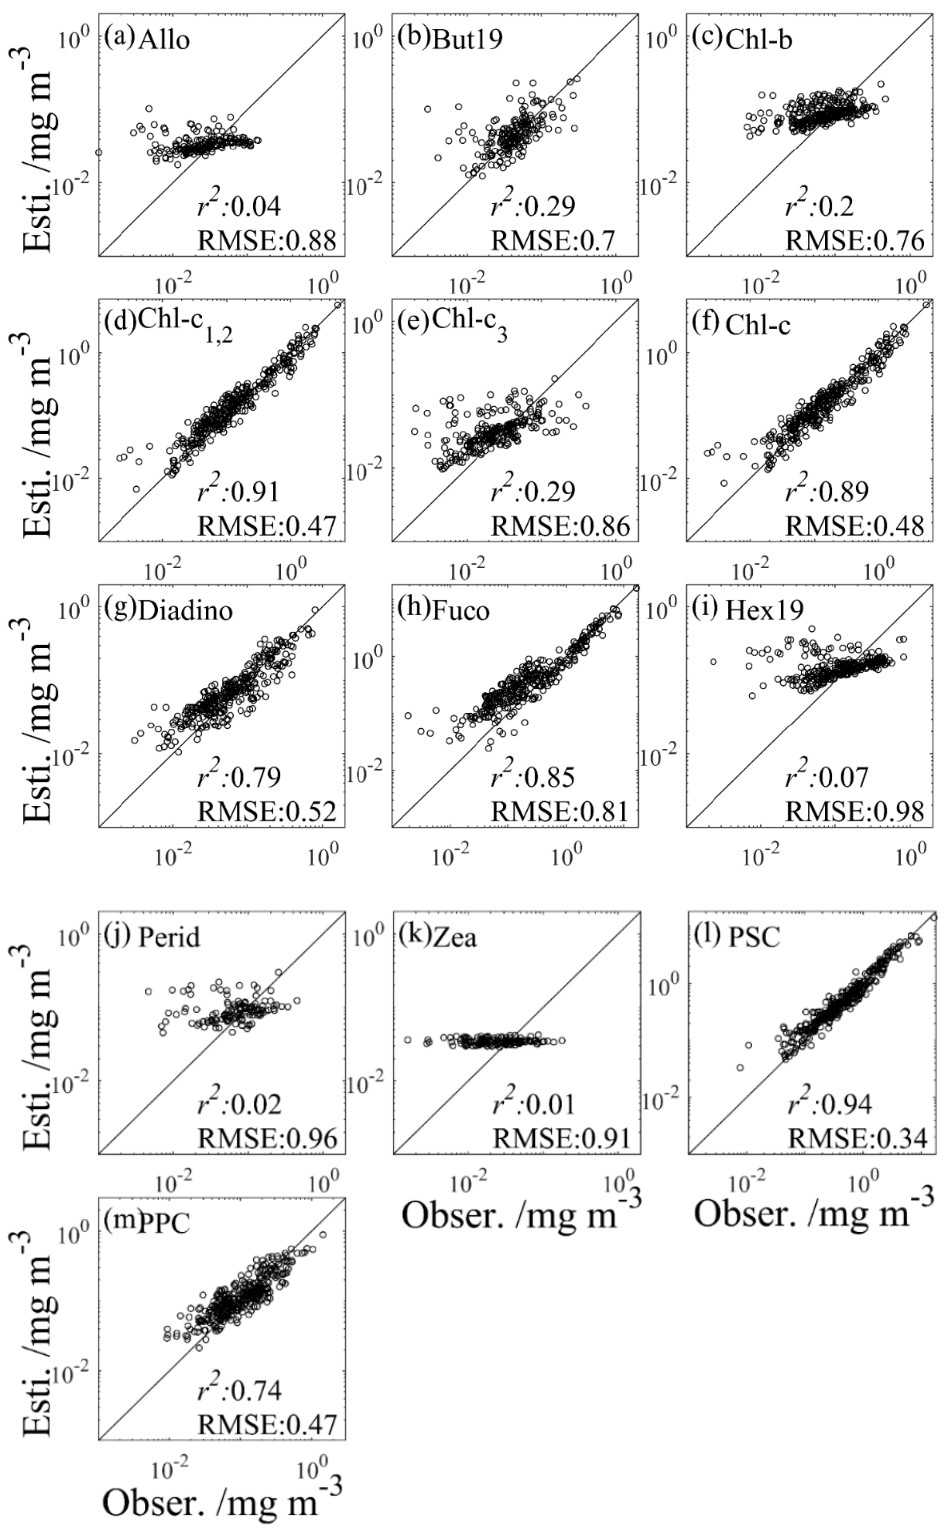
Figure 4. Observed concentrations (Obser.) versus concentrations estimated from the Chl-a model (Esti.) of 13 phytoplankton pigments ( a – m ) using the testing set. The black line represents the 1:1 line.